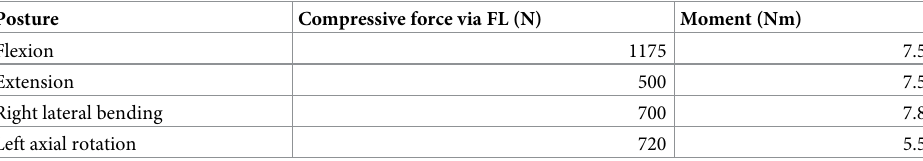
Table 3. Combined loading modes used for lumbar spine